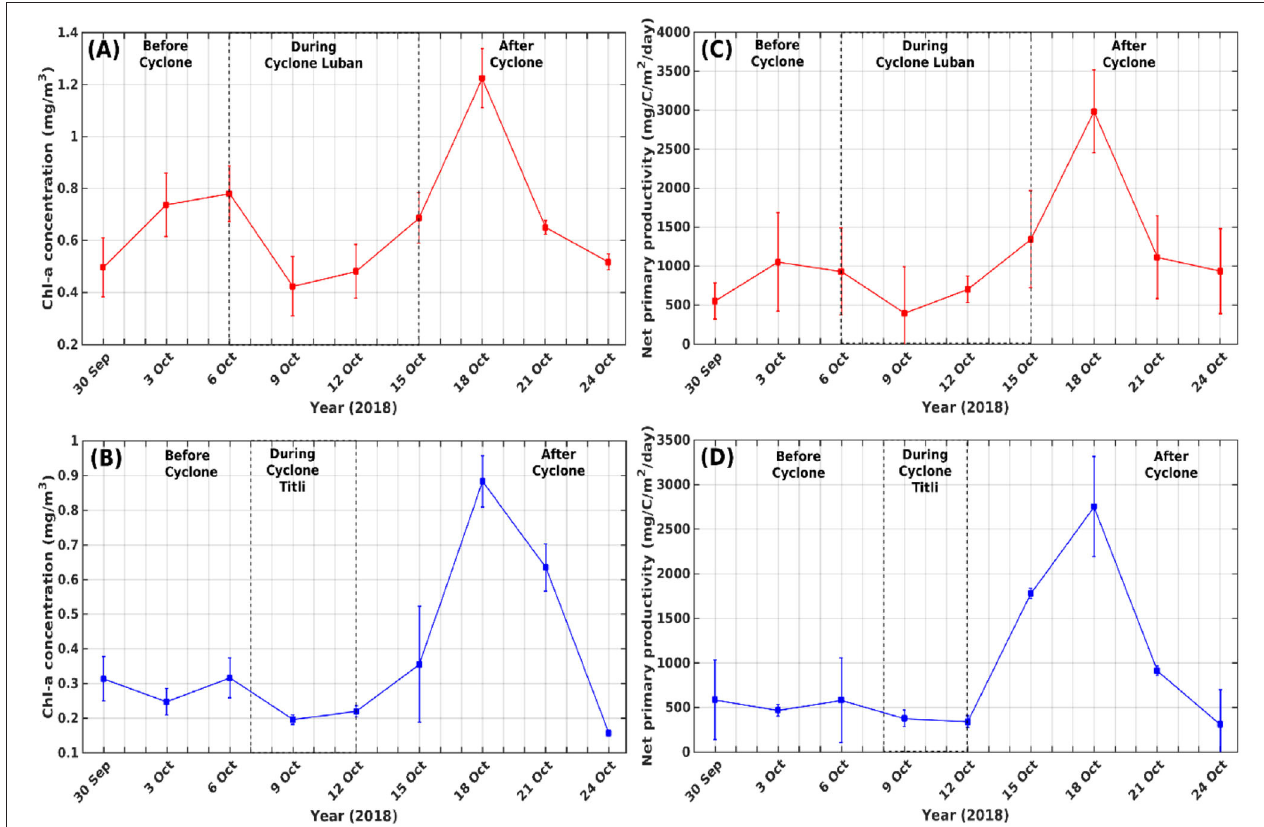
FIGURE 7 | Box-averaged 3-day mean chlorophyll a (Chl- a ) concentration (mg/m 3 ) and net primary productivity (mg/C/m 2 /day) before, during, and after the passage of cyclone Luban (A,C) and cyclone Titli (B,D) from September 29 to October 25, 2018. The box with a black broken line over the curve indicates the period of the